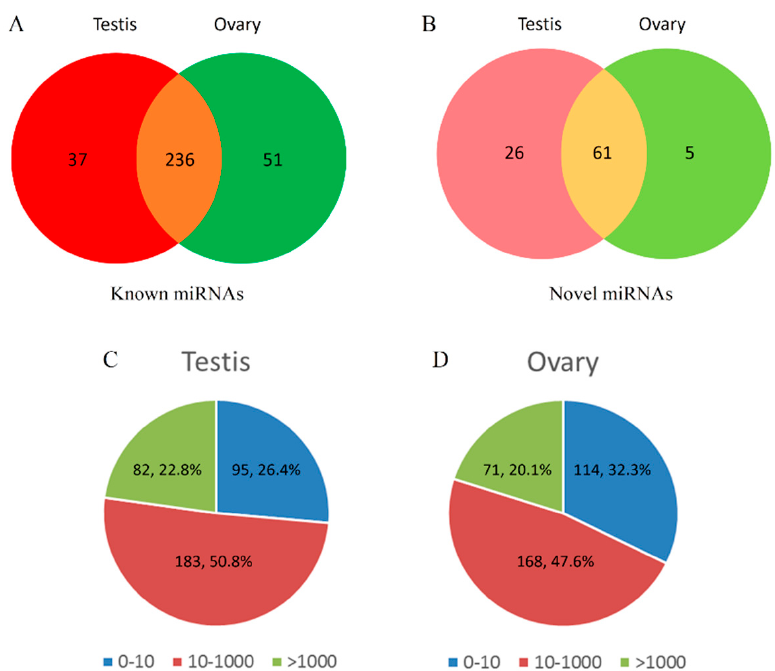
Figure 2. Overview of microRNA (miRNA) expression characteristics. Distributions of known miRNAs ( A ) and novel miRNAs ( B ) between the testis and the ovary. Read distribution intervals and the corresponding proportions in the testis ( C ) and the ovary ( D ).